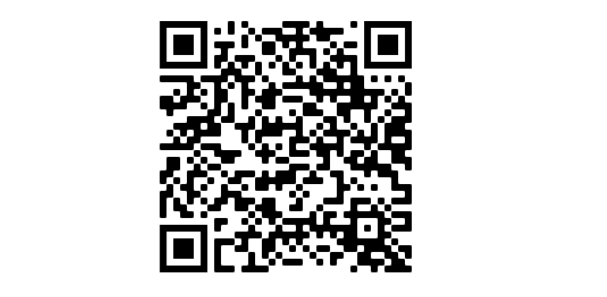
Fig. 1 - Chest tomography with inferior vena cava filter inside the right atrium.